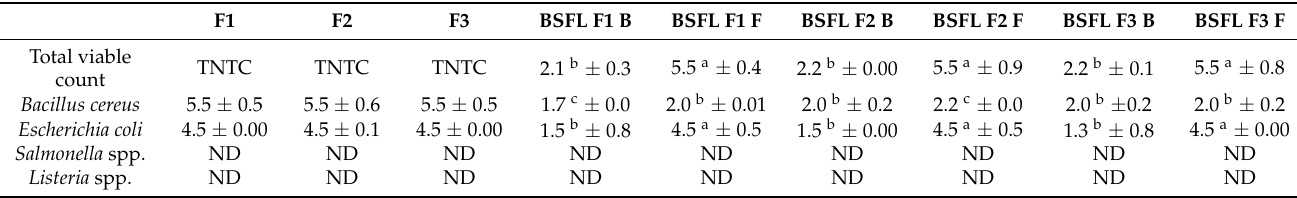
Table 3. Microbial results of feed and black soldier fly larvae grown on three different feeds after being frozen and blanched (log